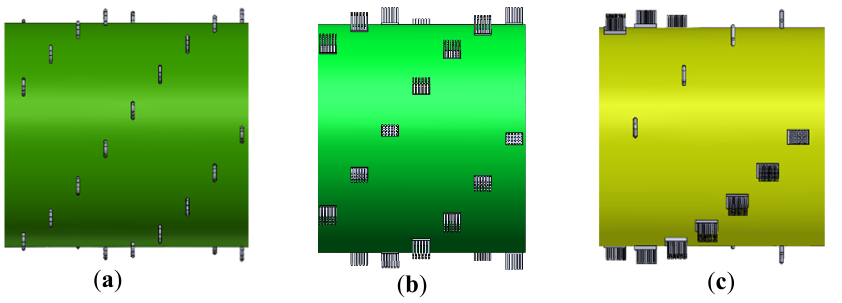
Figure 14. Separation element combination mode. ( a ). Only wire-loops distribution. ( b ). Only brush distribution ( c ). Cross distribution of bow tooth brushes.